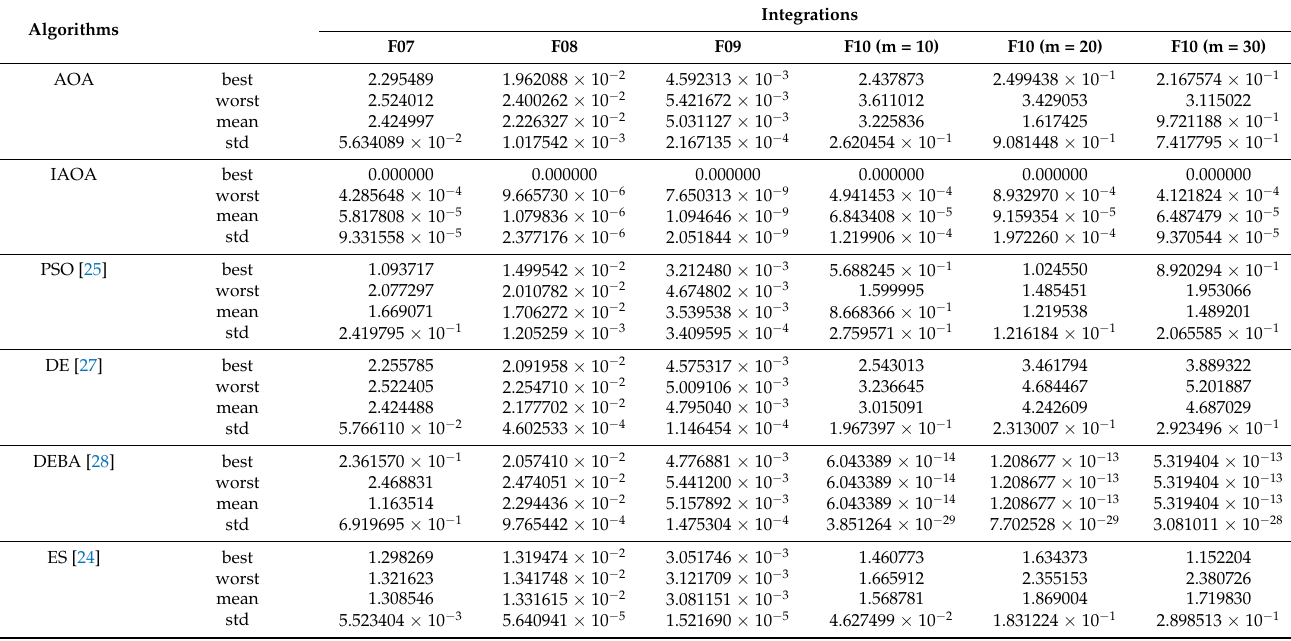
Table 14. Statistical results for numerical integrations